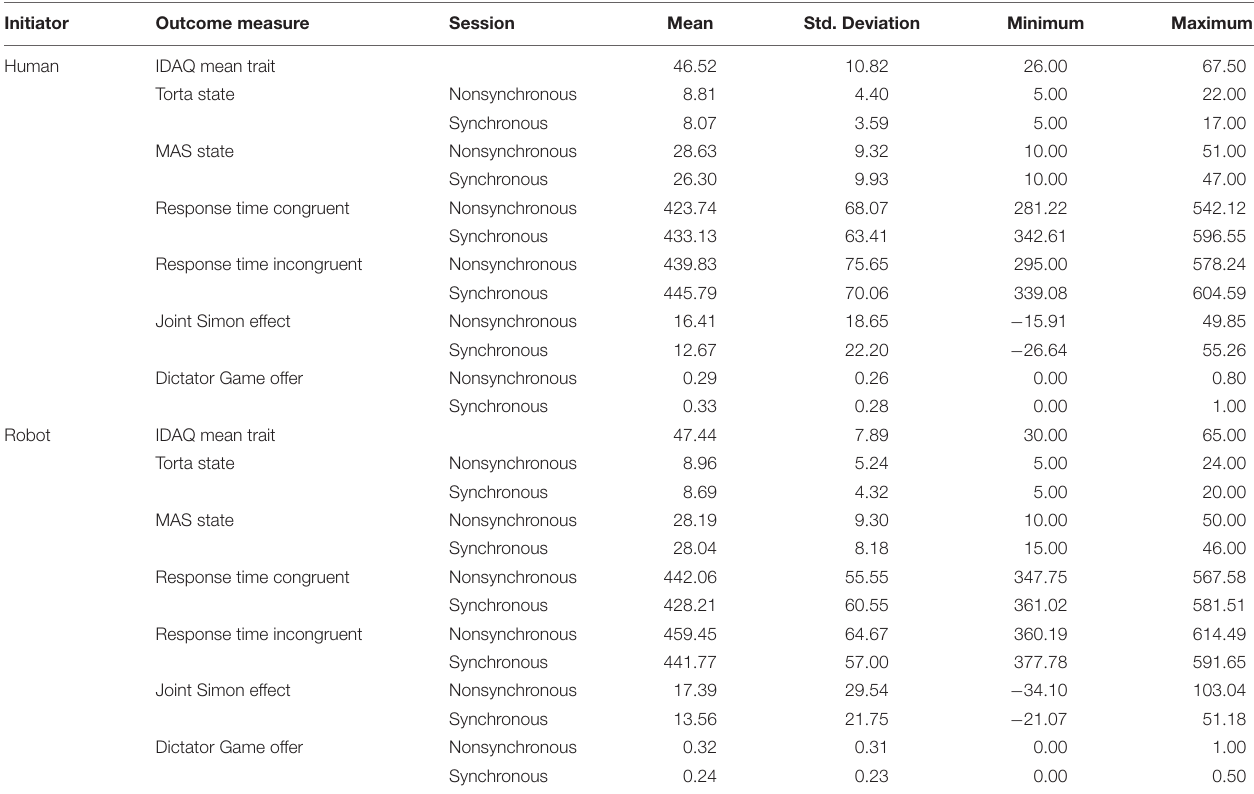
TABLE 1 | Descriptive statistics.